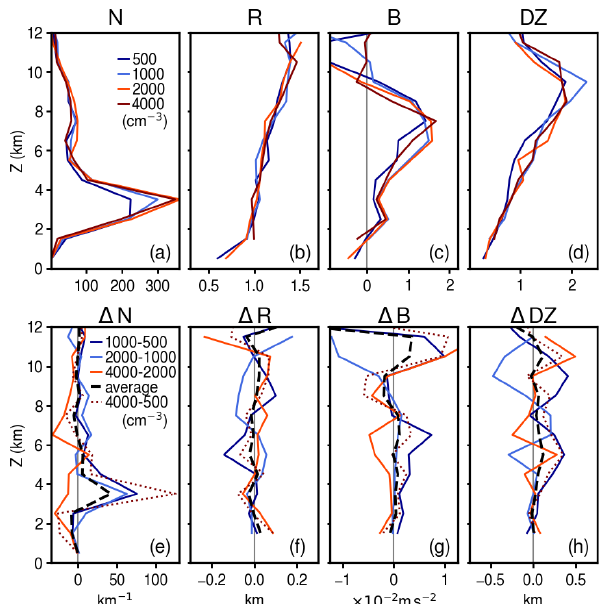
Figure 6. Vertical profiles of the (a) number of thermals (per ver- tical kilometer), (b) average thermal radius, (c) average buoyancy, and (d) average vertical distance traveled by thermals for the dif- ferent aerosol number concentrations (see the legend). Panels (e) through (h) show the differences in the quantities of panels (a) through (d) between successive pairs of profiles (continuous colored lines), their average change (dashed black line), and the change be- tween the two extreme cases, i.e., 4000 and 500cm − 3 (dotted color